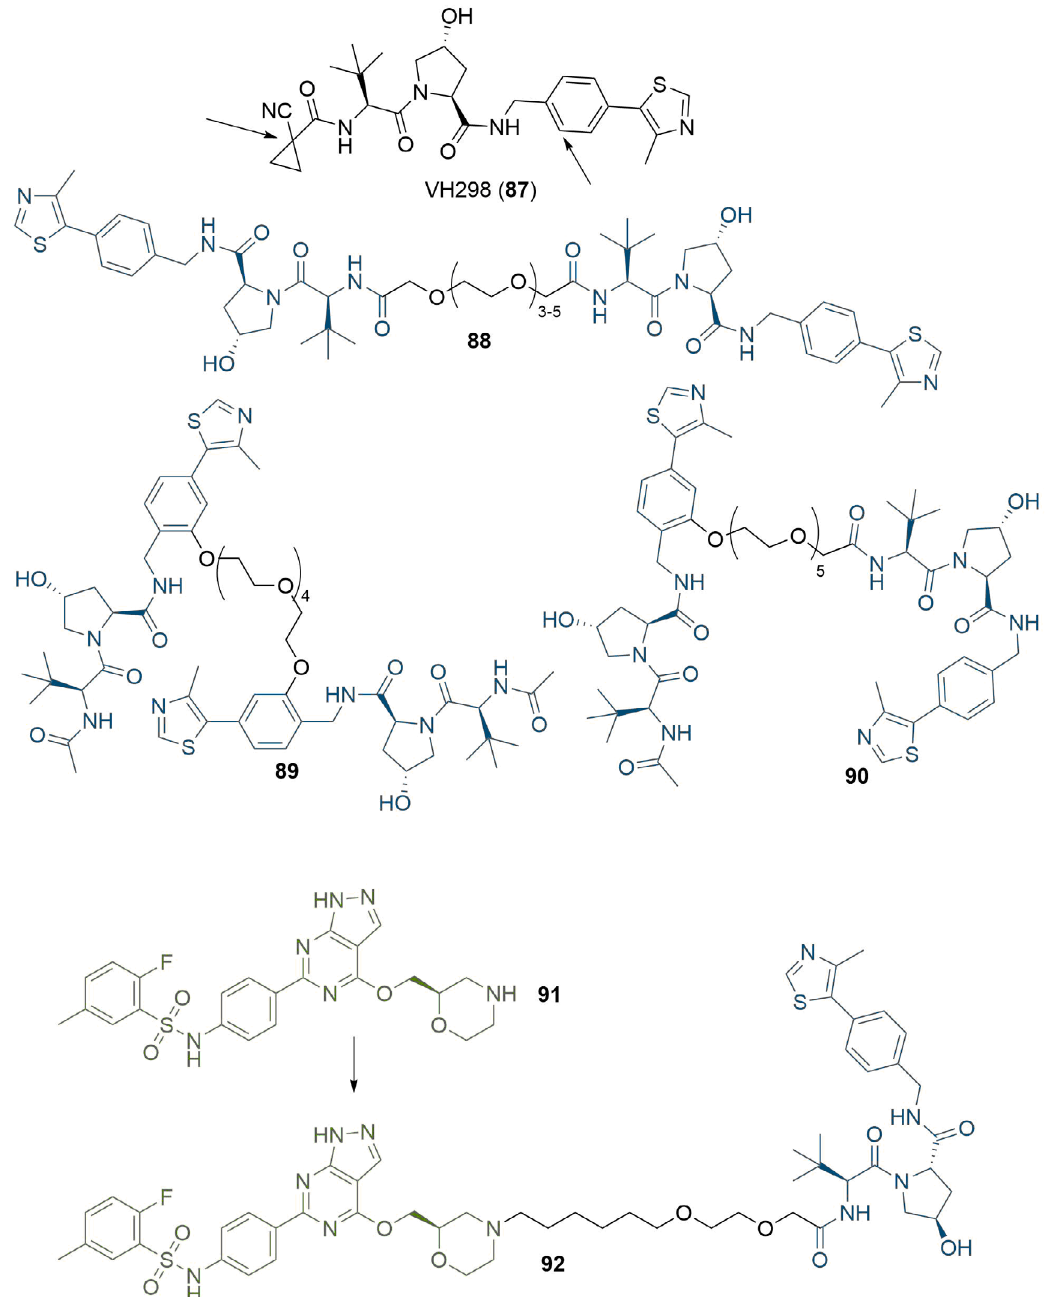
Figure 18. Use of co-crystal structures to identify linker conjugation sites. Arrows indicate sites on VH298 (87) that are solvent exposed. This was used to inform the design of three combinations of analogous VH032 (8) in homo-PROTACs 88-90. The morpholine nitrogen in SGK3 inhibitor 91 was shown to be solvent-exposed, and was used for linker conjugation in PROTAC